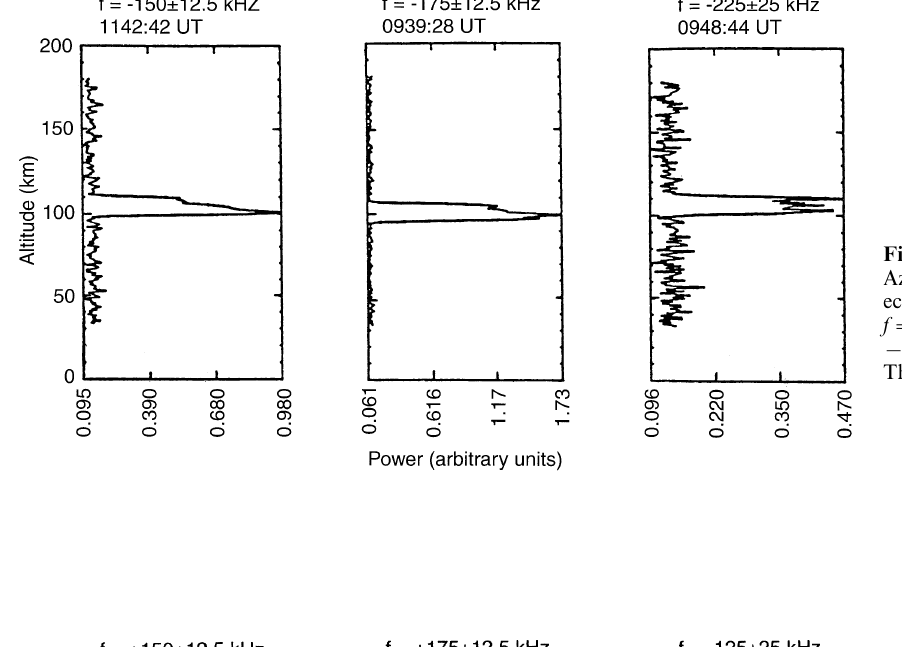
Fig. 9. Power profiles on 26 March 1995 for Az " 45 ° and El " 10 ° . The figure shows